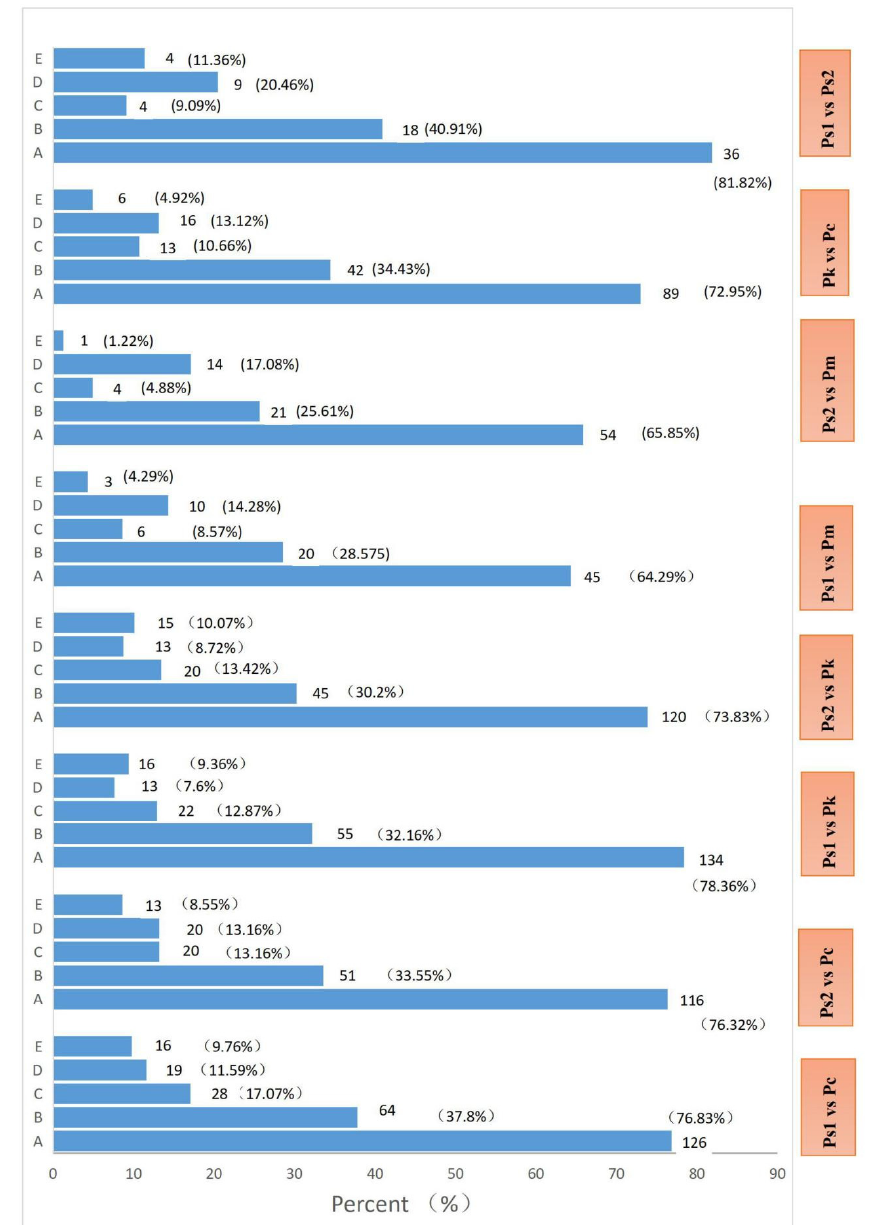
Figure 5. Five enriched KEGG pathways among the differentially abundant metabolites detected in eight comparisons ( A, Metabolic pathways; B , Biosynthesis of secondary metabolites; C , Biosynthesis of amino acids; D , Flavonoid, isoflavonoid, flavone, and flavonol biosynthesis; E , 2-Oxocarboxylic acid metabolism). The abscissa presents the proportion of metabo- lites assigned to a pathway.